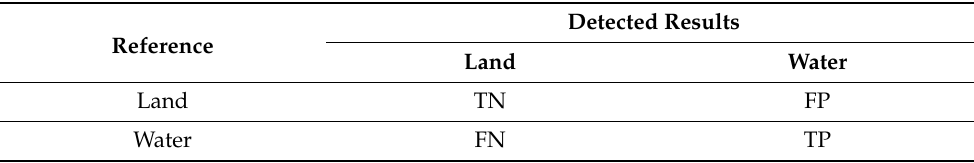
Table 2. Confusion matrix of the inland water detection.